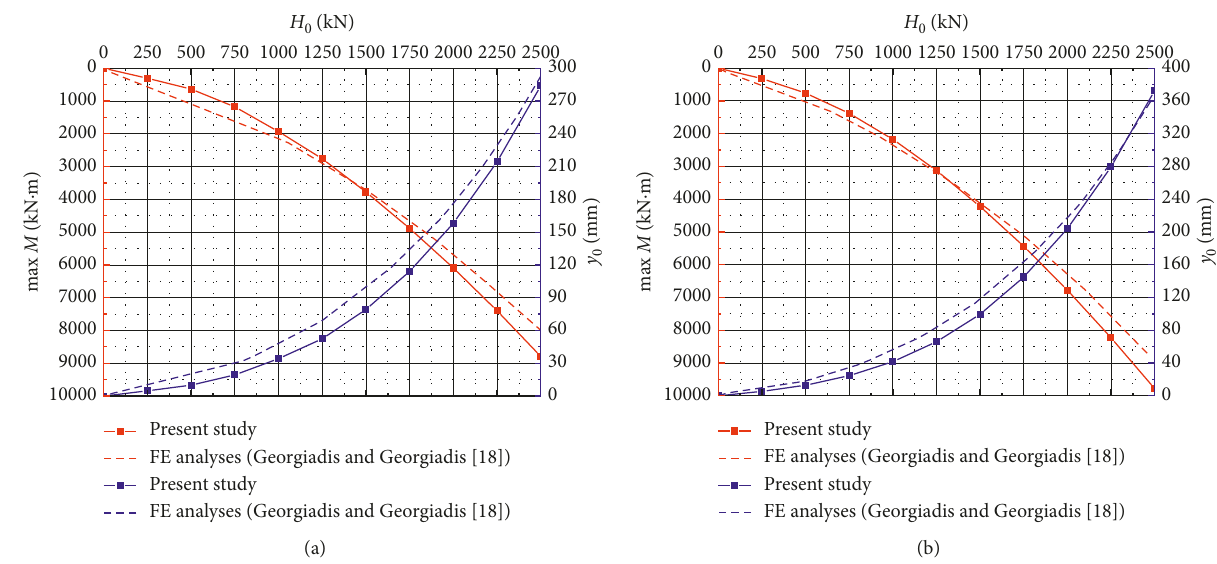
Figure 7: Verification analysis of H 0 - y 0 curves relationship for FE analysis. (a) θ (cid:31) 20 ° (b) θ (cid:31) 40 °